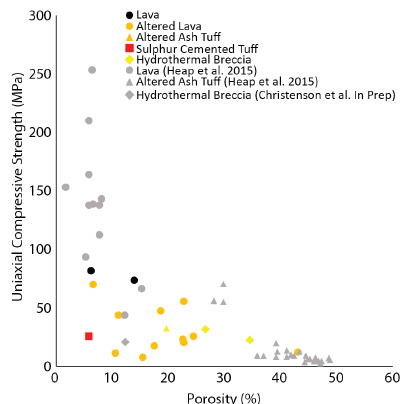
Figure 8. Uniaxial compressive strength (UCS) as a function of porosity for samples from this study and from [13,59].